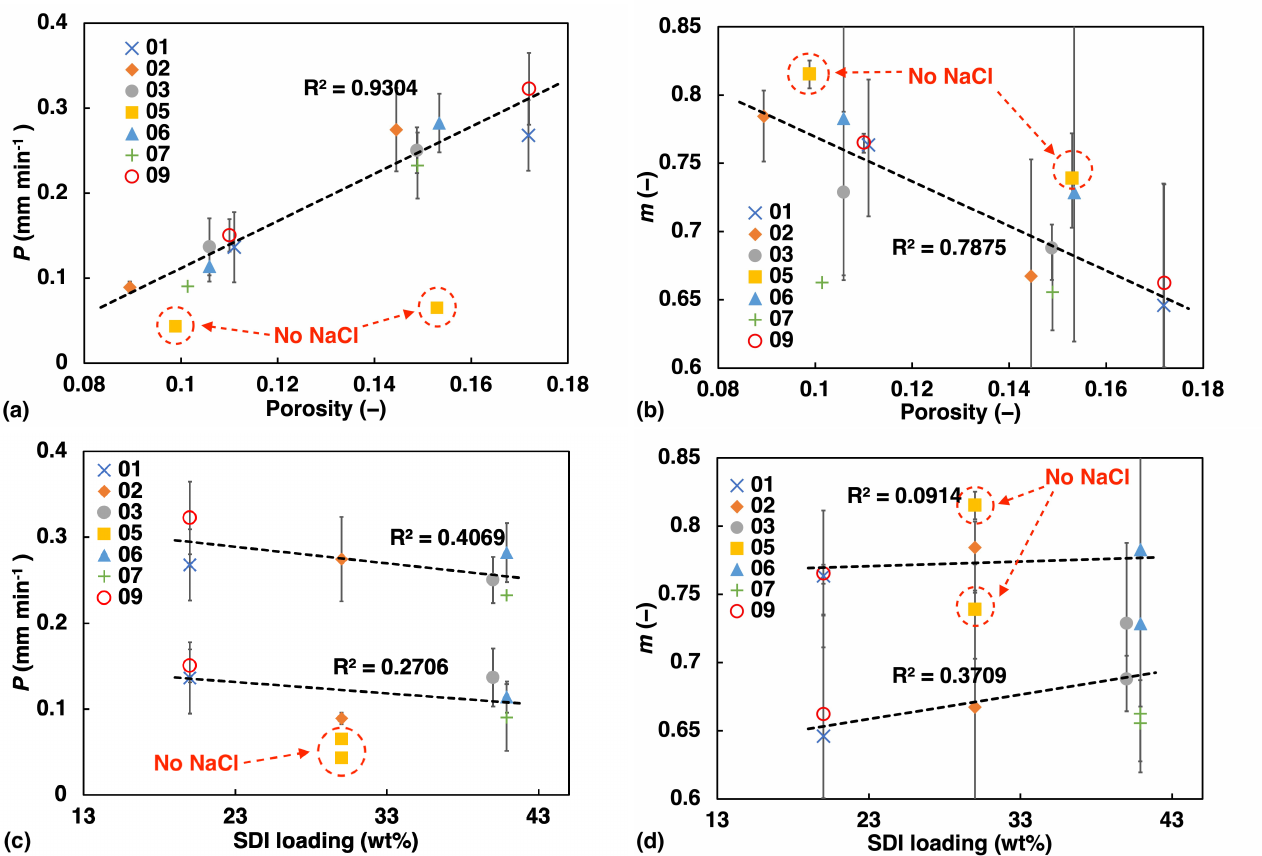
Figure 5. Liquid transport as quantified using the power-law fit of the TPI measurement data plotted against porosity ( a , b ); and against SDI loading ( c , d